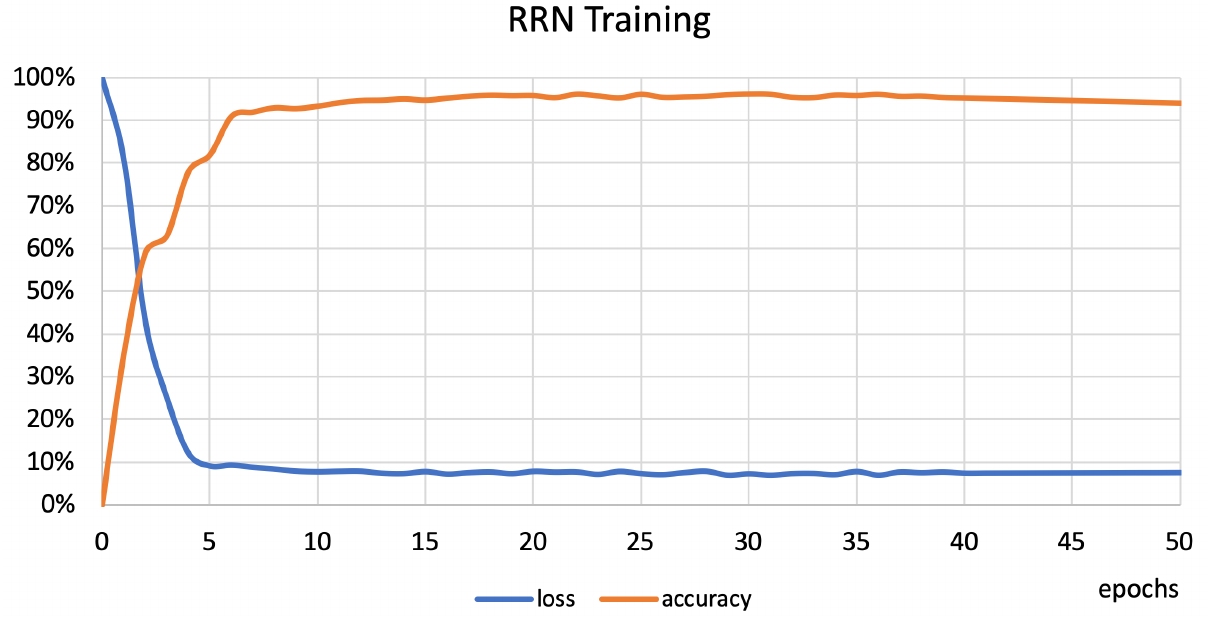
Figure 5. Training of the RNN